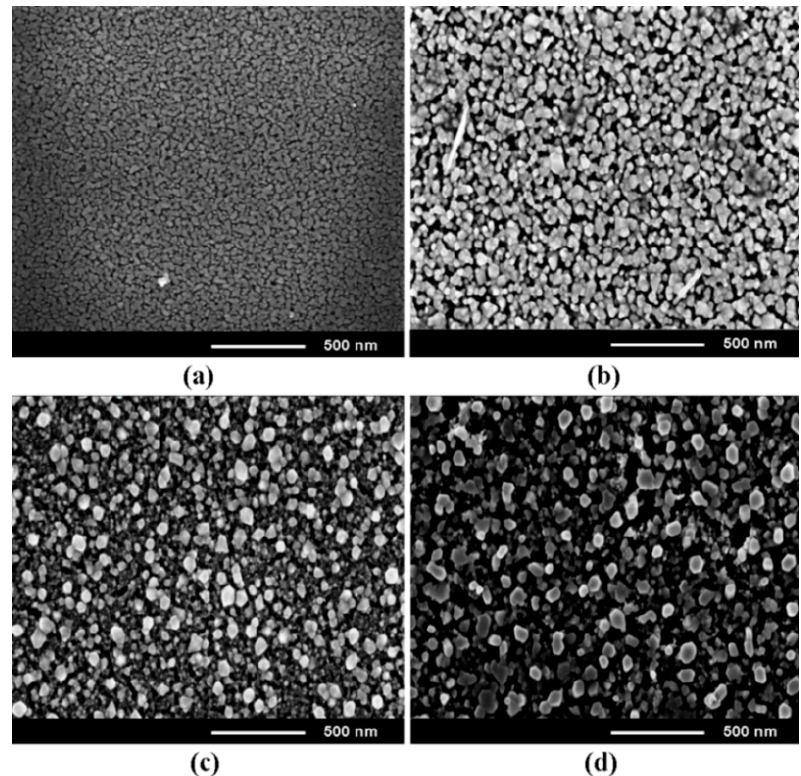
Figure 1. SEM images, top view of Zn 0.5 Mg 0.5 O films deposited by spin coating and annealed in air for 15 min ( a ), 30 min ( b ), 45 min ( c ), and 60 min ( d ). The XRD analysis (Figure 2) suggests that concomitantly with increasing the crystallite sizes, the crystal quality of the deposited films improves with increasing the annealing time, as indicated by the enhancement of the intensity of XRD reflexes from the wurtzite phase indexed according to the PDF Card No. 01-078-3032. At the same time, the (200) reflex from the rock salt phase appears at annealing durations longer than 45